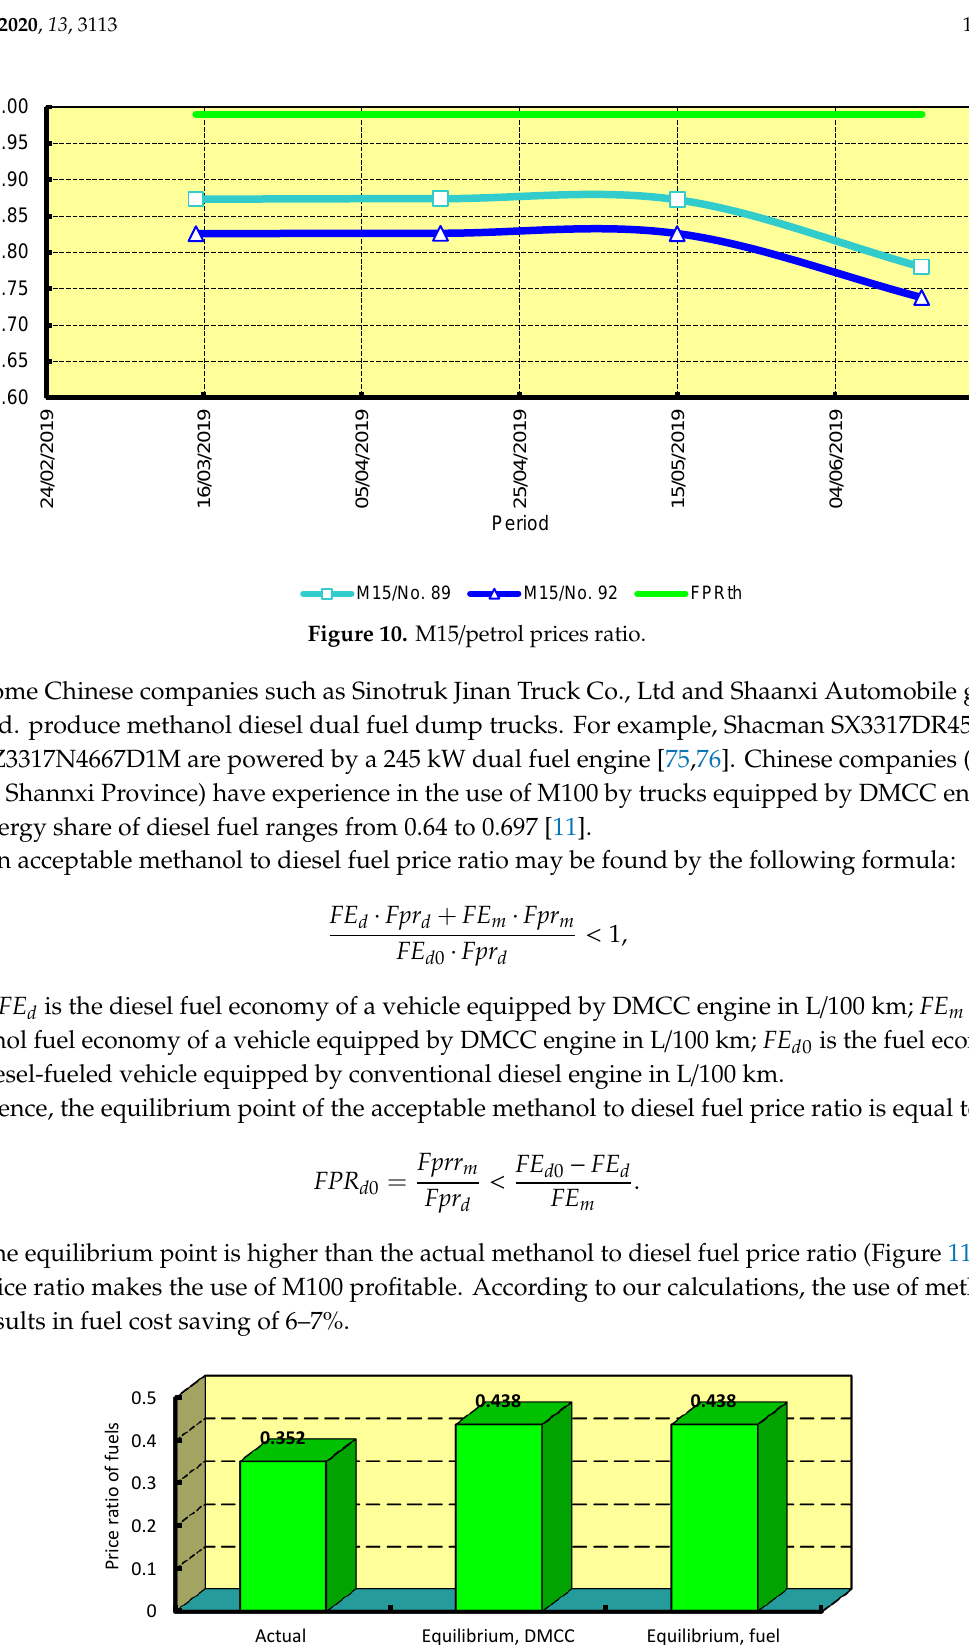
Figure 11. Methanol to diesel fuel price ratio: actual, maximum acceptable.